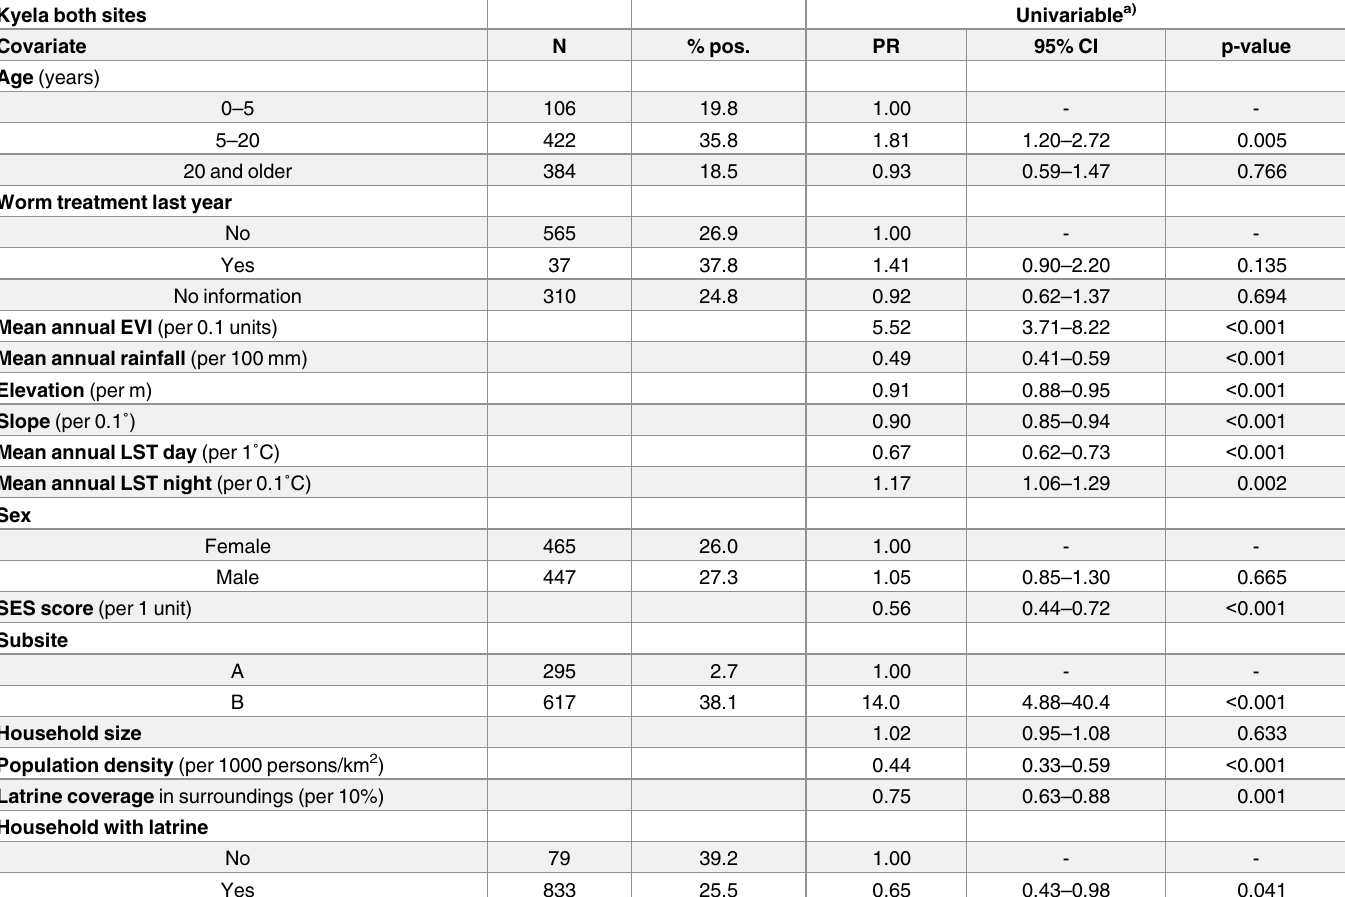
Table 2. Univariable association of different factors with T . trichiura infection in Kyela. Results of univariablePoissonregressionmodels adjustedfor household clustering using robust varianceestimates (N = 912). Kyela both